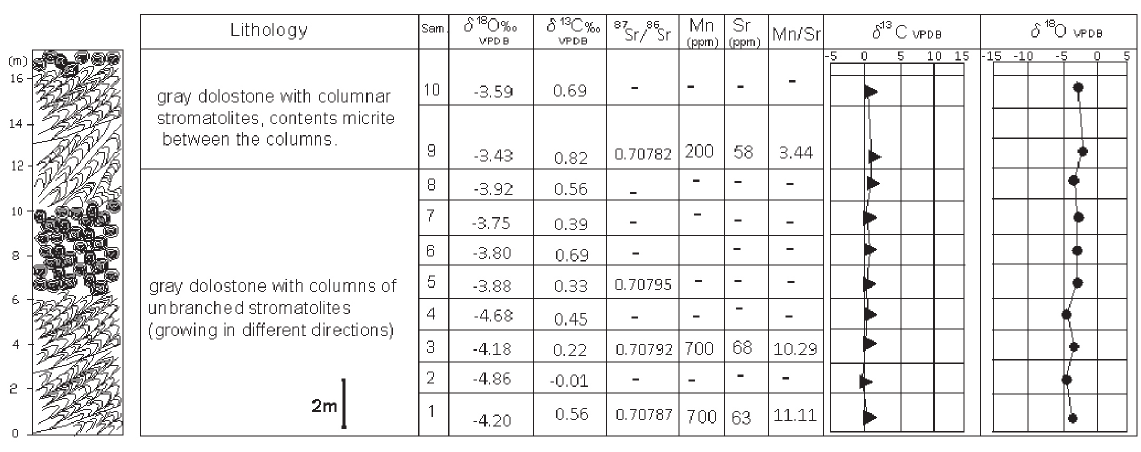
Figure 7 - Lithological variations, elemental and isotopic data in stromatolitics dolostone lenses of the section along the Jequitinhonha River (see Fig. 2 for location).